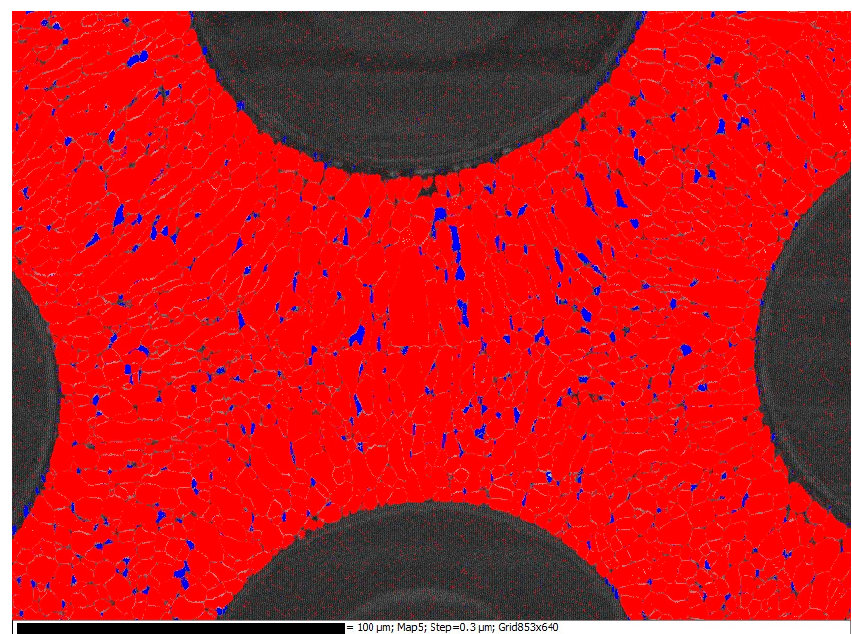
α in red with intergranular β in blue.